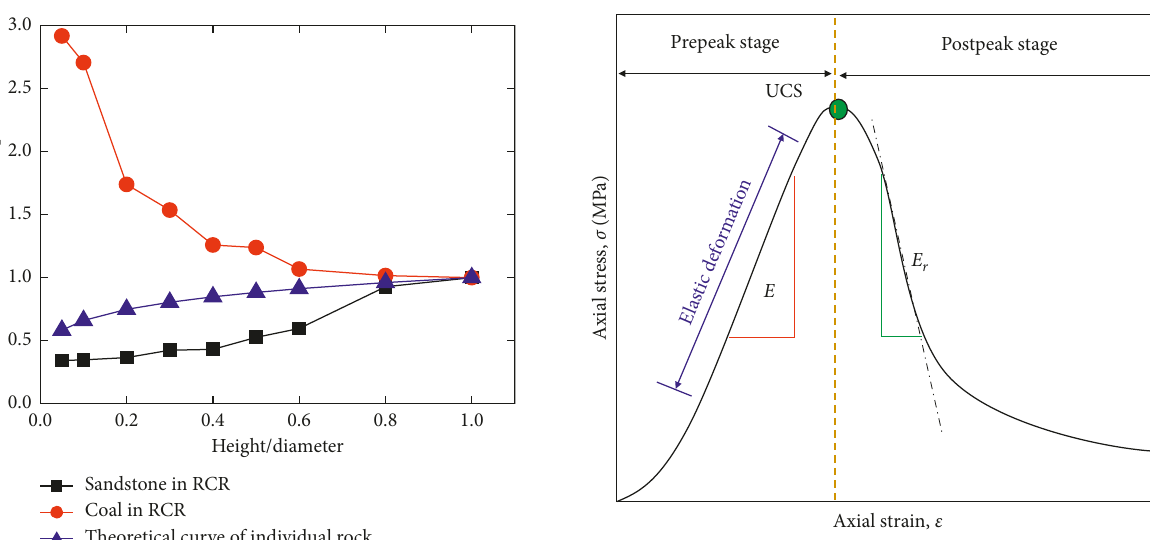
Figure 7: Size effect on the UCS of the samples.